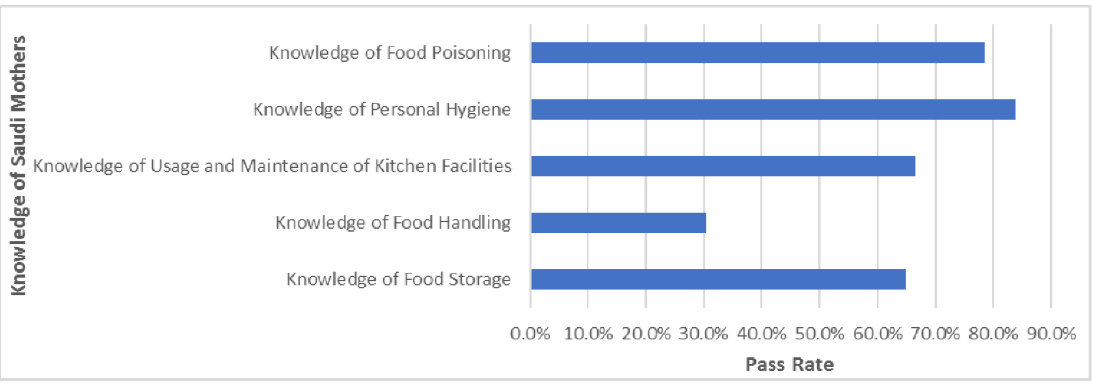
Figure 1. Pass rate for knowledge of food safety among Saudi mothers (Knowledge levels—Low: Pass rate up to 30%; Moderate: Pass rate 30–60%; High: Pass rate above 60%). Mothers between the age of 36–50 year were better with food safety knowledge and practices with a pass rate of 41.6%. Housewives were more knowledgeable with a pass rate of 53.8% and those who had four or more children reported a better pass rate of 45.7%. Additionally, results showed that higher monthly income Saudi mothers were better with their food safety knowledge and practices and had a pass rate of 57.3%.